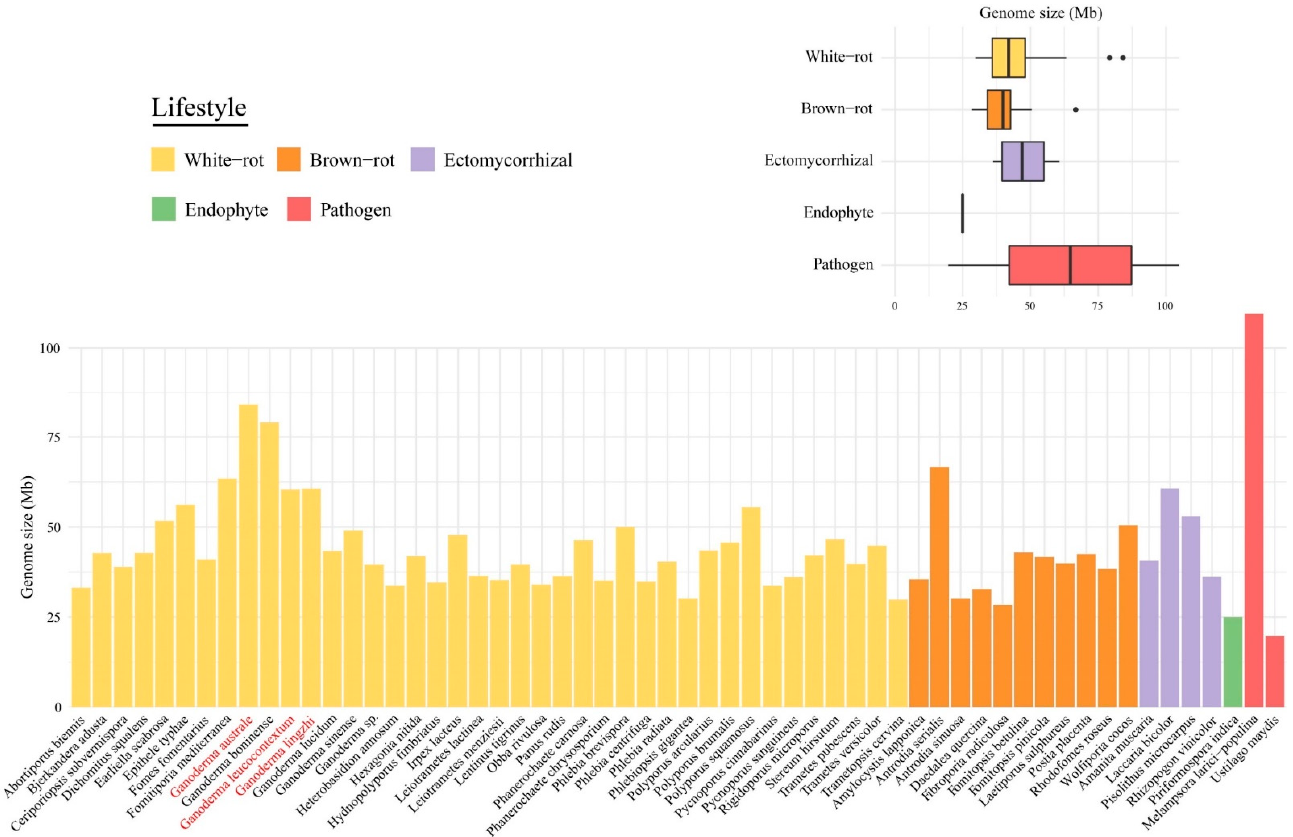
Figure 1. Comparison of the genome size among the 58 selected species. Bars represent size of 58 genomes and boxplots show proportion of genome size in different lifestyles. The new genomes are shown in red.